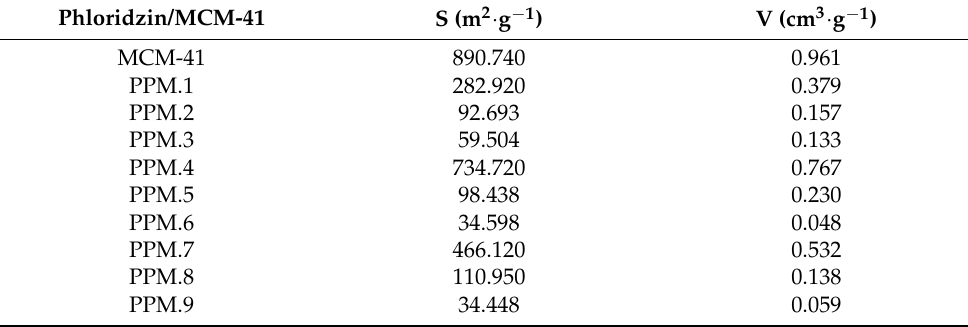
Table 6. Specific area and pore volume of MCM-41 before and after